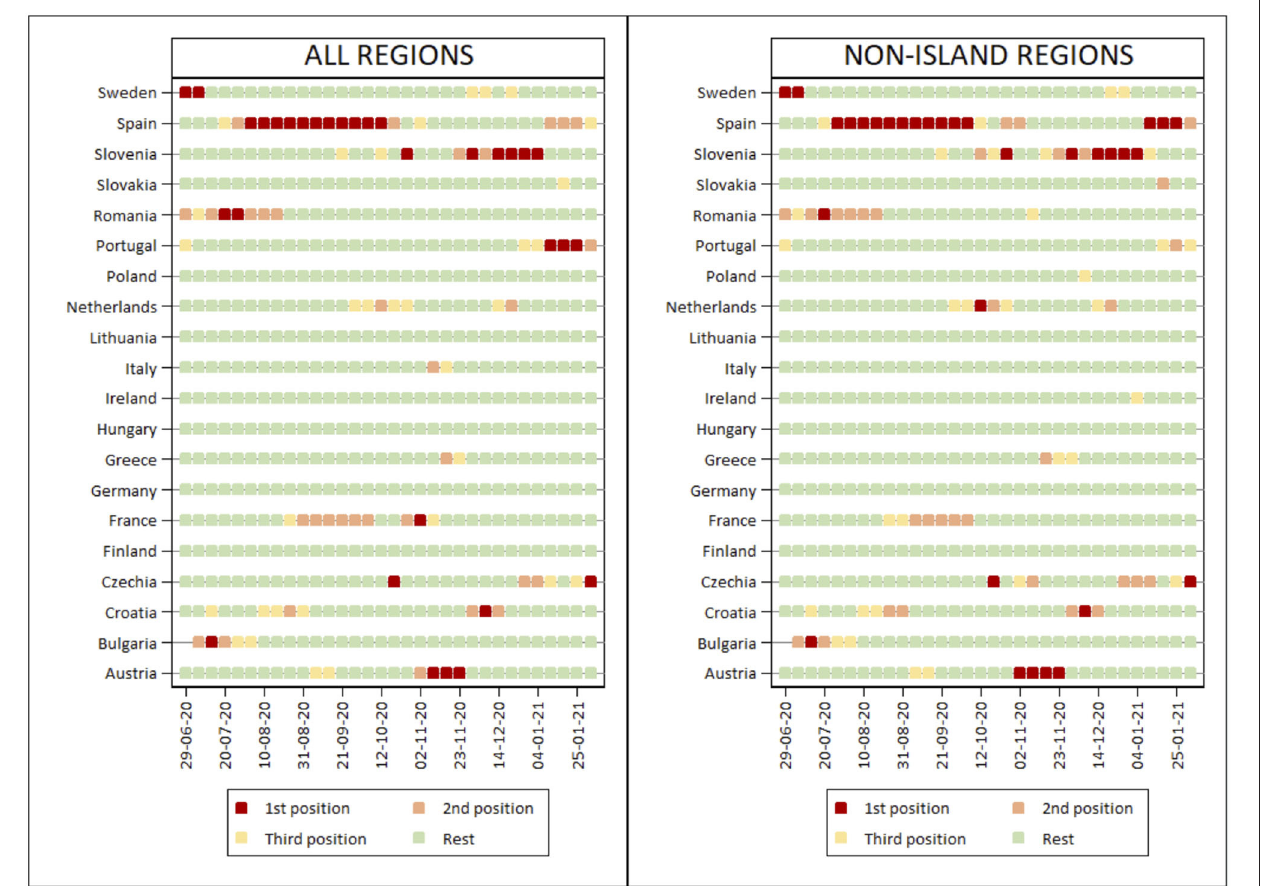
FIGURE 2 | Ranking held by countries in each week of the period analysed according to their interquartile range, in descending order of